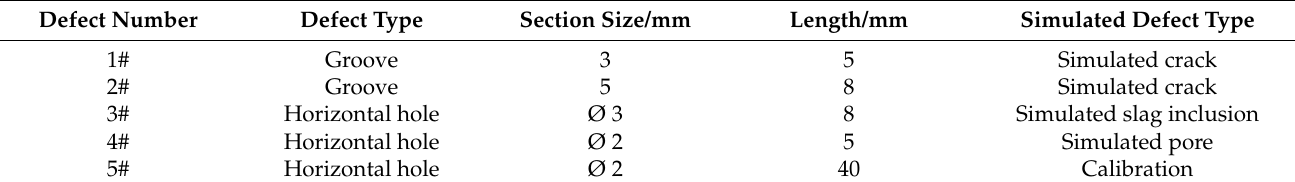
Table 1. Artificial defect parameters.